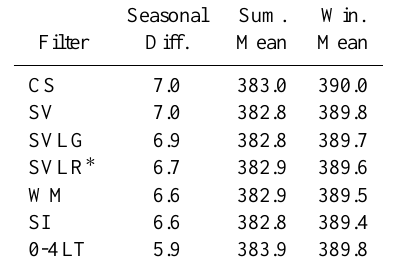
Table 3. The strength of seasonal cycle of CO 2 mole fractions is listed by the difference between seasonal means representing the annual maximum (February, March, April) and minimum (August, September, October) values in ppm CO 2 (asterisk indicates SVLR statistics exclude HDP data). Seasonal Sum.